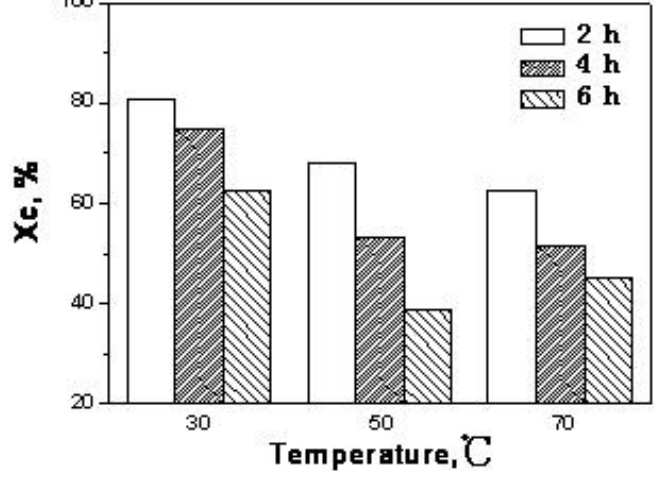
Figure 1. Effect of temperature on decrystallization of MCC with phosphoric